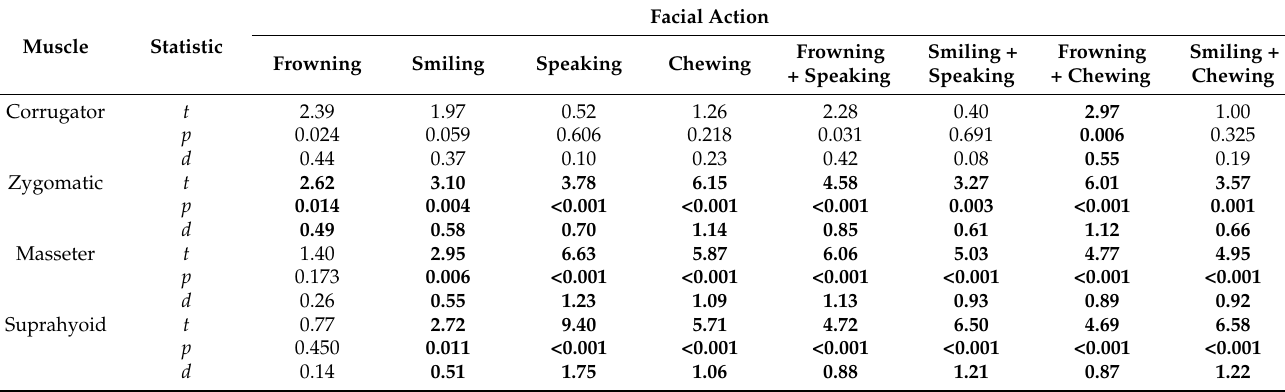
Table 2. Results of paired t -tests (two-tailed) comparing original and independent component analysis-reconstructed